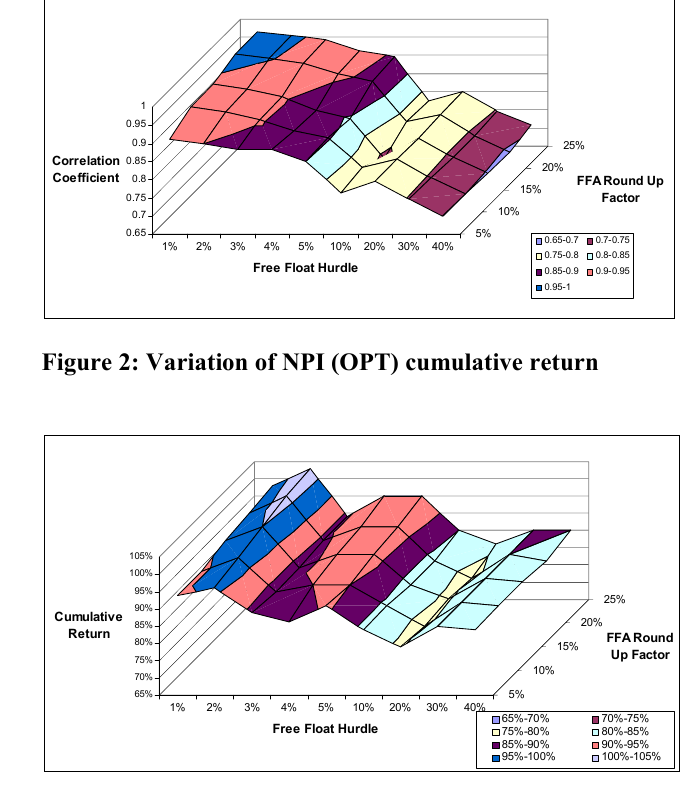
Figure 3: Variation of correlation between NPI